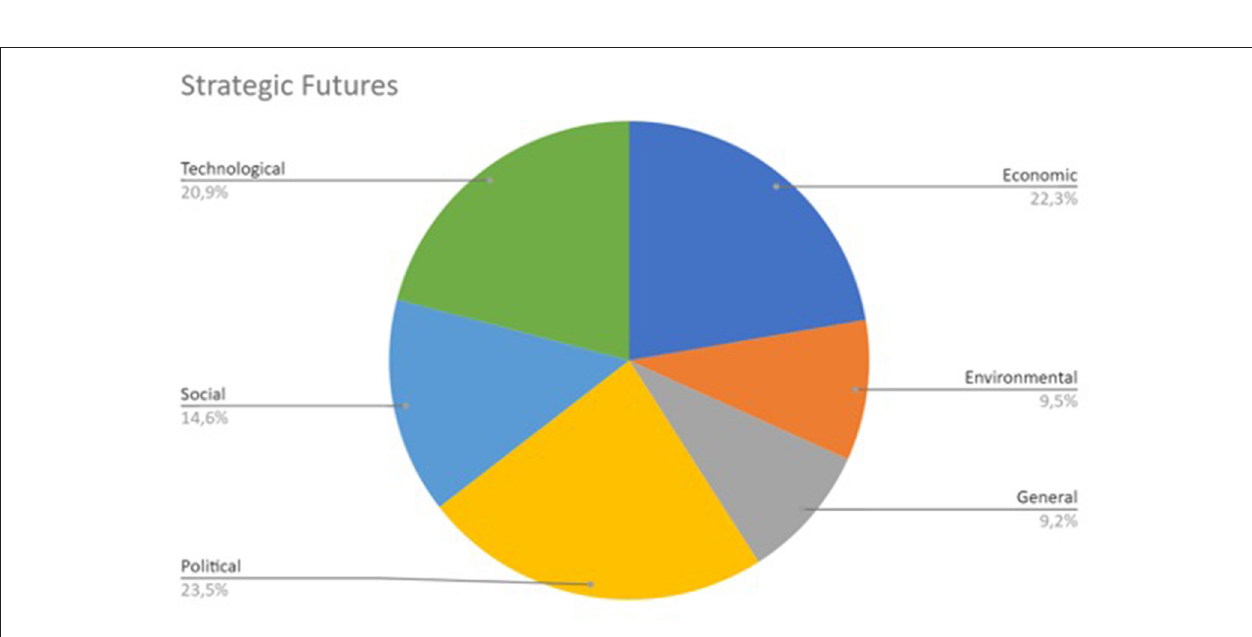
FIGURE 2 | Visualizing the different types of expected futures, and the topic: economic, environmental, social, political, general, and technology.